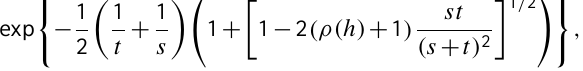
Algorithm M8 is based on a simple